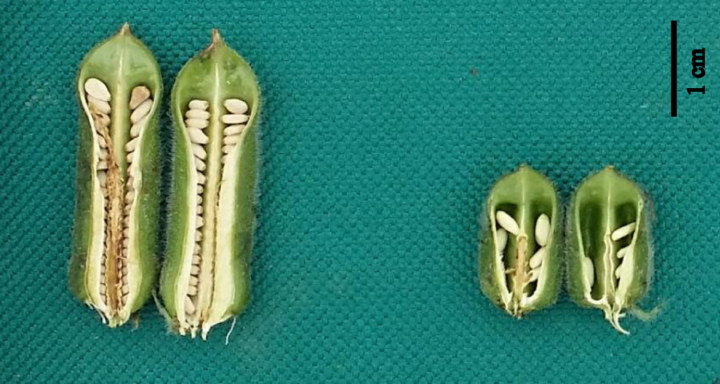
Figure 1. Phenotypic comparison of the capsule and seeds between Yuzhi 11 (left) and cs1 (right).